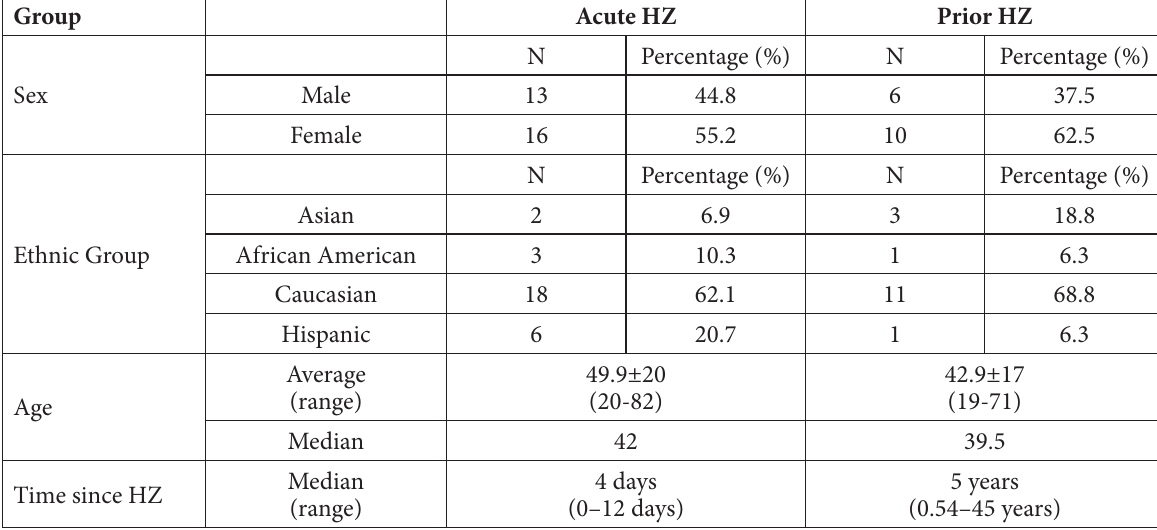
Table 1. Individual Demographics and Clinical Information